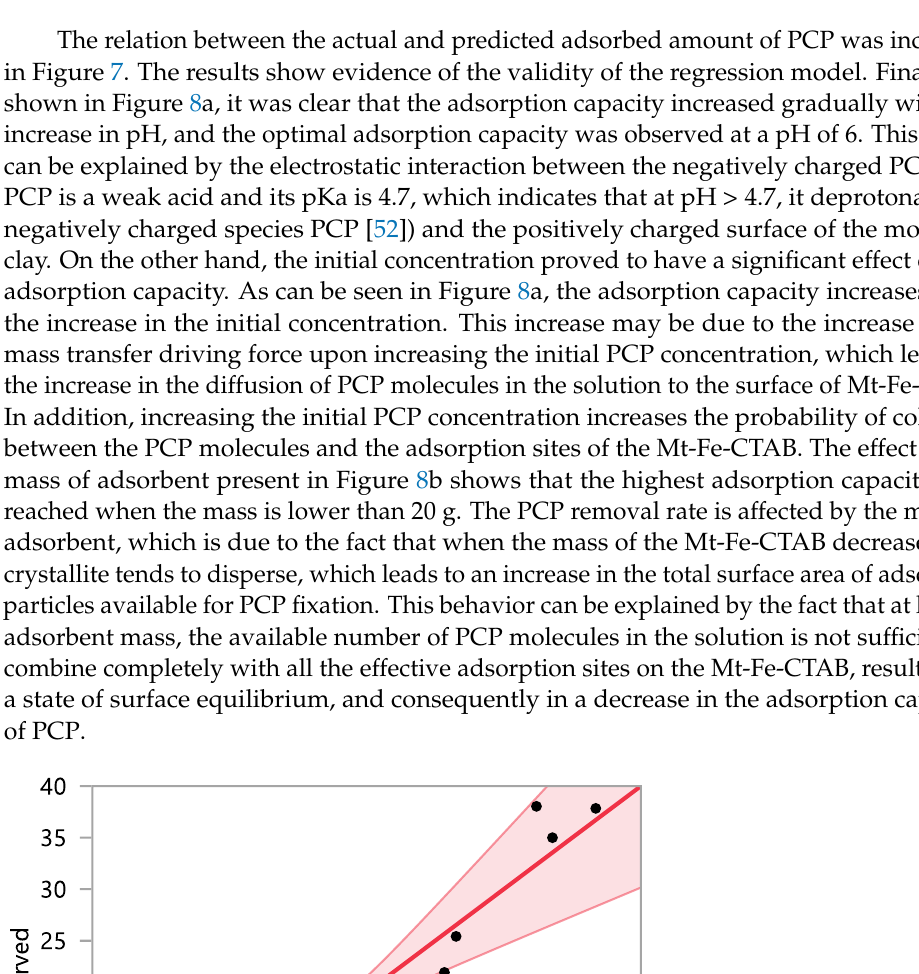
Table 5. Estimated regression coefficients and corresponding F- and p-values for adsorbed PCP.